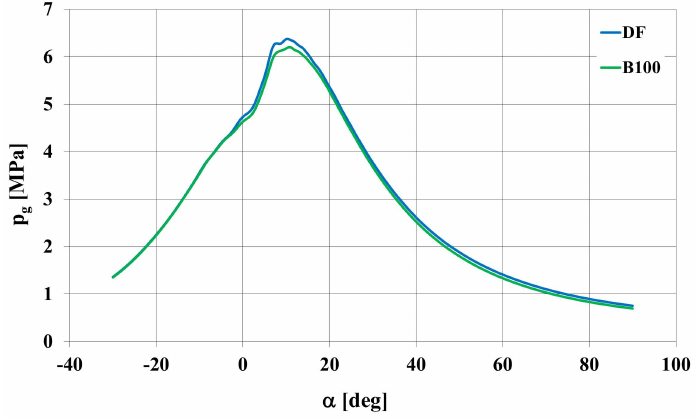
Figure 14. Process in the pressure of the working factor in the cylinder-p g in the domain of the crankshaft rotation angle- α at the rotation speed of 3600 min- 1 for the engine powered with fuels DF diesel or B100.